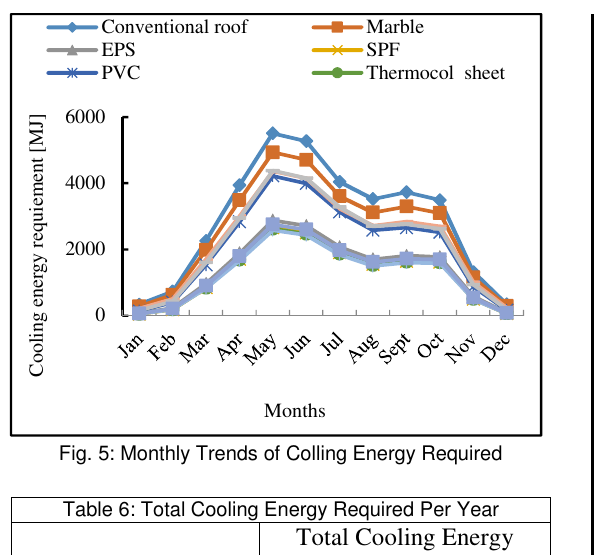
Fig. 5: Monthly Trends of Colling Energy Required Table 6: Total Cooling Energy Required Per Year